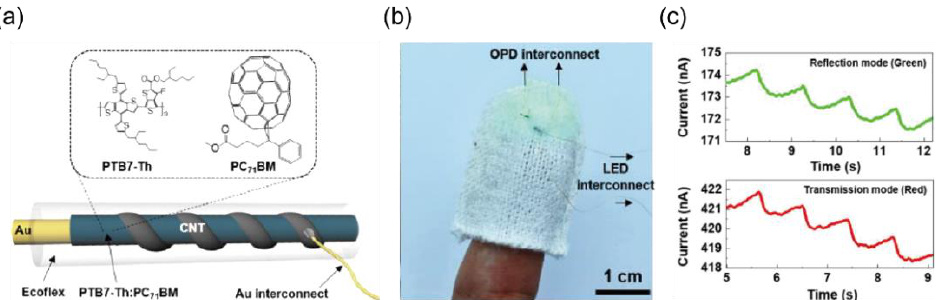
Figure 15. ( a ) Sectional view of green OLED, OPD, and red OLED in a complete OPO sensor. ( b ) Image of the proposed OPO sensor with an enlarged cross-sectional view to depict the device arrangement and light-receiving process through the skin. The picture of an OPO sensor in operation is also shown. Note that the Figure 8-shaped OPD wraps around red and green OLEDs in operation. ( c ) PPG signals, SpO2 values, and heart rate obtained from various body parts. ( d ) Comparison of the power consumption of R and G light sources of oximetry sensors: †, discrete optical elements integrated on a PCB substrate with the edge-to-edge distance between elements being 2 mm (=PO1); ‡, a commercially available reflective pulse oximetry head (SFH7050, Osram Sylvania Inc.) (=PO2); ††, OPO sensor wherein rectangular OLEDs and OPDs are arranged side by side with an edge-to-edge distance of 2 mm (=PO3); ‡‡, the OPO sensor proposed in this work (=PO0). The layer configurations of OLEDs and OPD in the OPO sensor used in †† are identical to those used in this work. Adapted with permission from [41], AAAS, 2018.